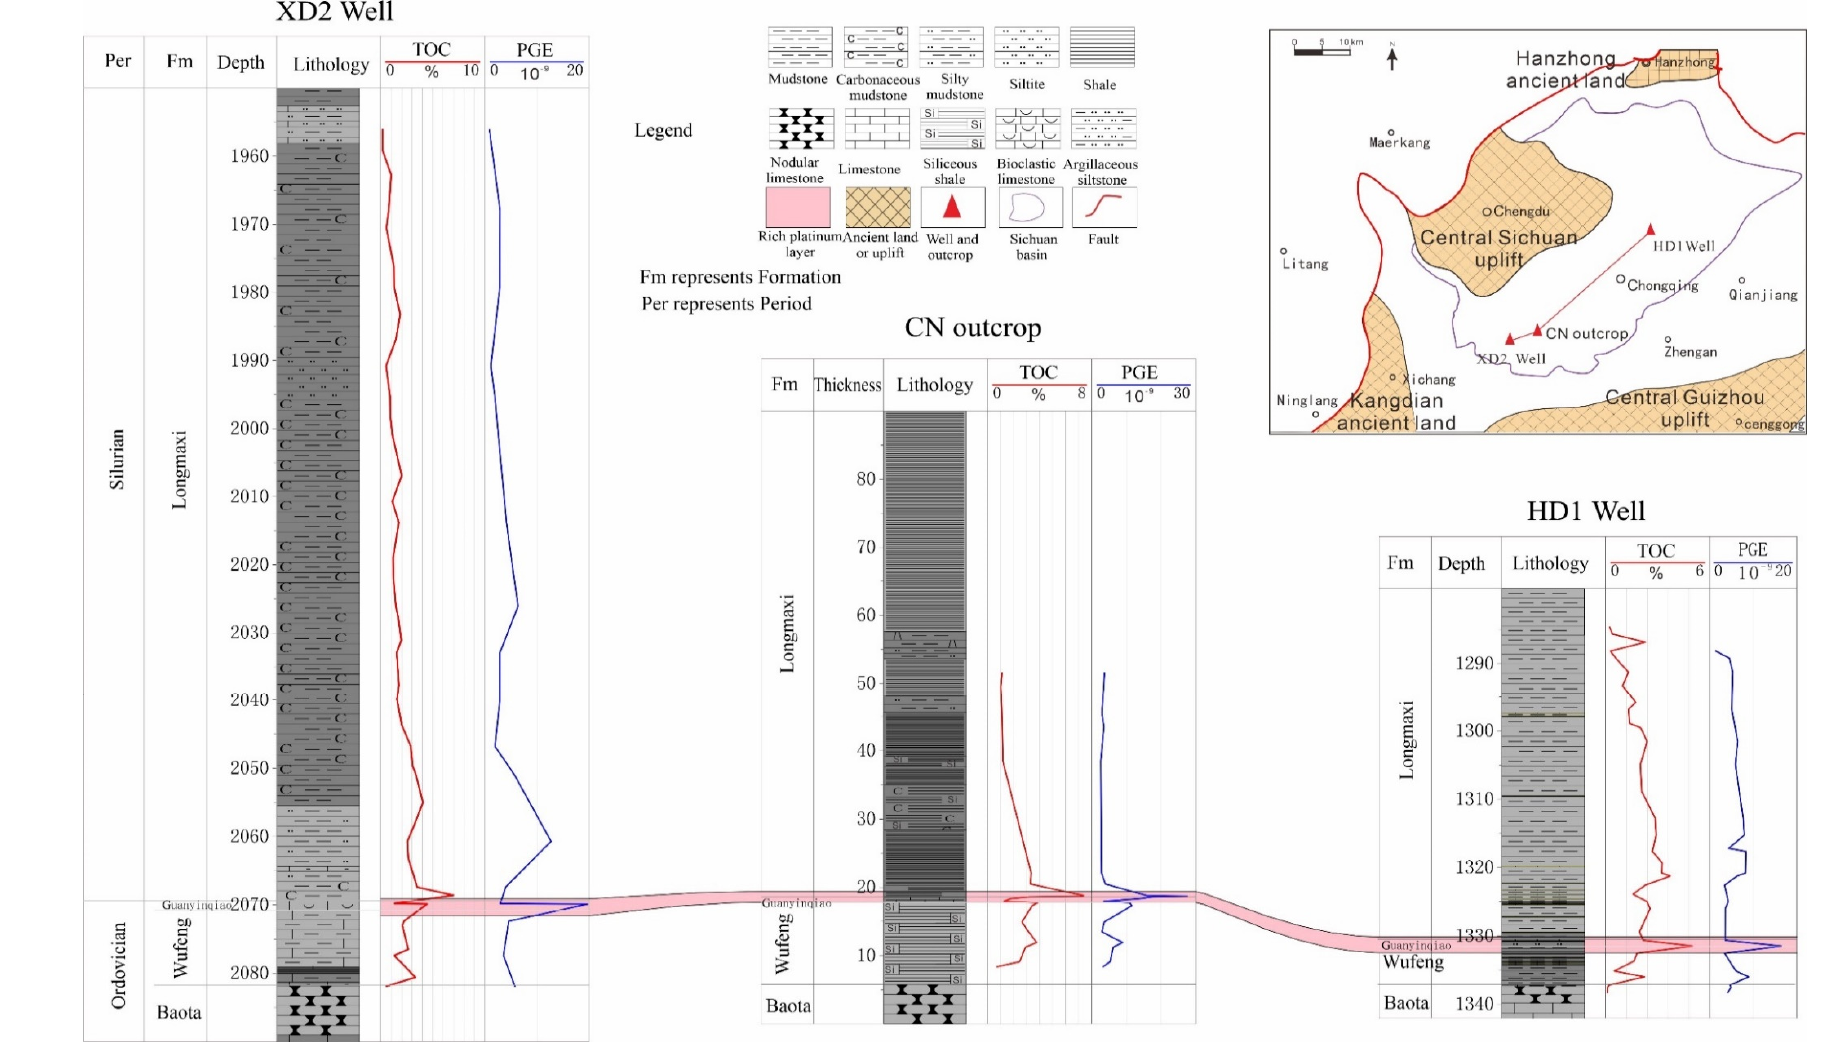
Figure 1. Well Connection Diagram of Wufeng and Longmaxi Fm in Sichuan Basin.